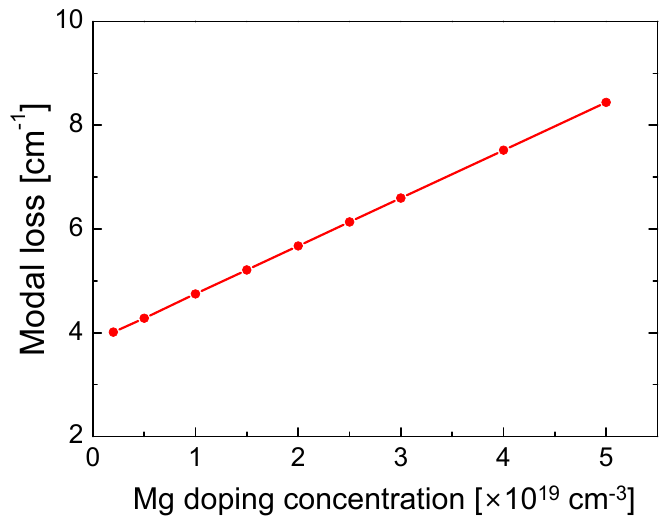
Figure 8. Modal loss of the LD structure as a function of Mg doping concentration.